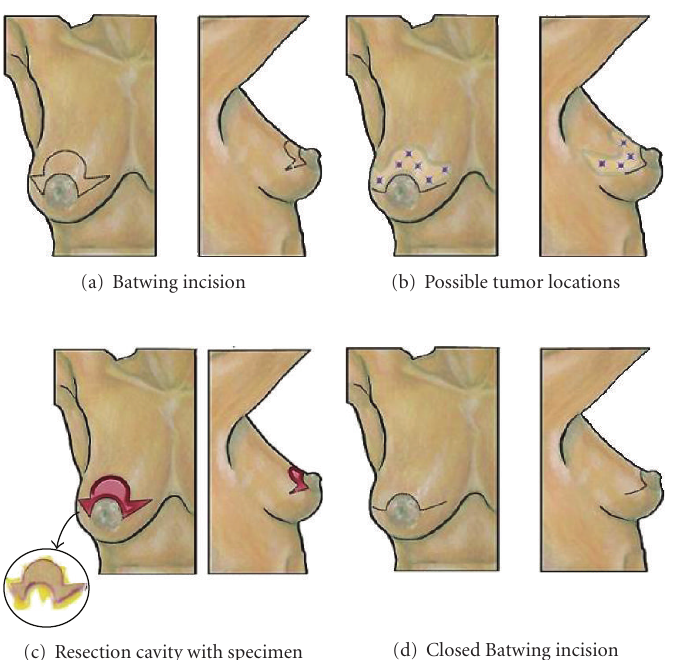
Figure 5: Batwing resection. (a) Shows location of batwing skin incision. (b) Shows multiple “stars” indicating possible tumor locations suitable for this approach. (c) Shows resection cavity of batwing resection with excised specimen (inset). (d) Shows breast following closure of the hemibatwing